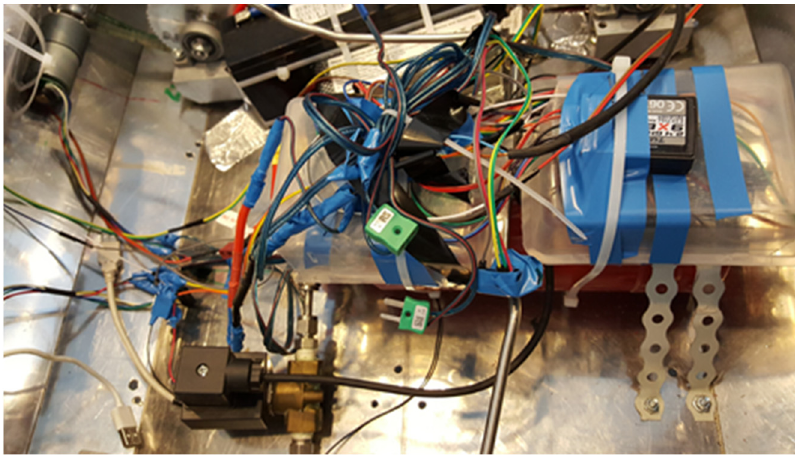
Figure 1. Sensor systems of FFR-1 UTM (Firefighting Robot 1 from Titu Maiorescu University).